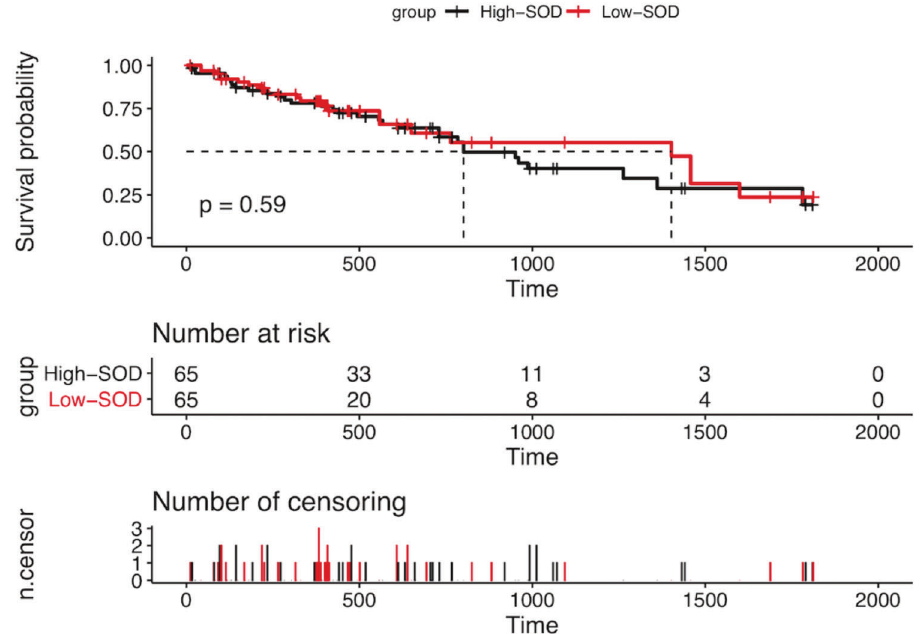
Figure 2 - Kaplan-Meier curves of the high- and low-SOD groups. The 5-year OS rate in the low-SOD group was higher than the 5-year OS in the high-SOD group, but the difference was not statistically significant (stratified log-rank, p =0.585). SOD, serum superoxide dismutase; OS, overall